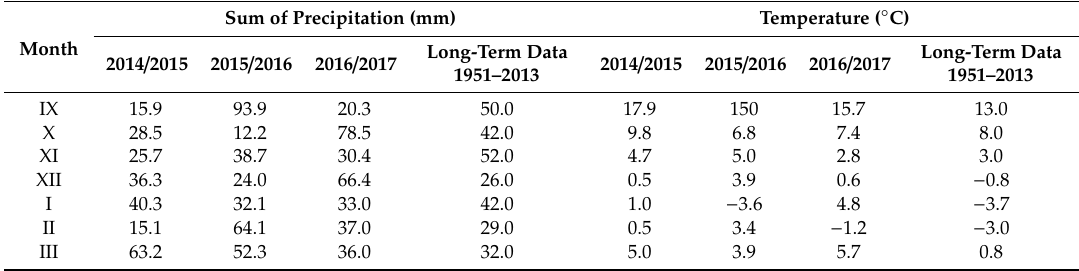
Table 2. Total precipitation and average monthly temperatures in Grab ó